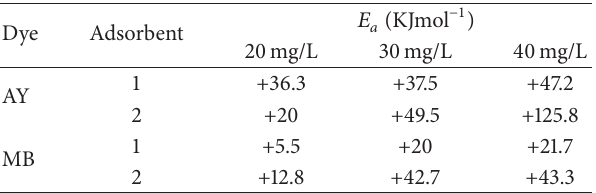
Table 5: Thermodynamic parameters for the adsorption of AY and